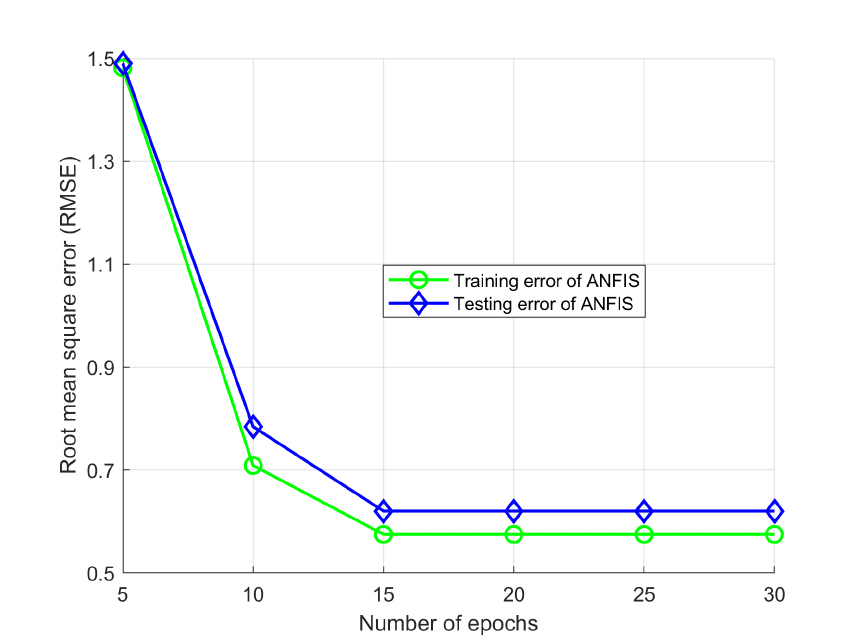
Figure 7. Training and testing errors according to the number of